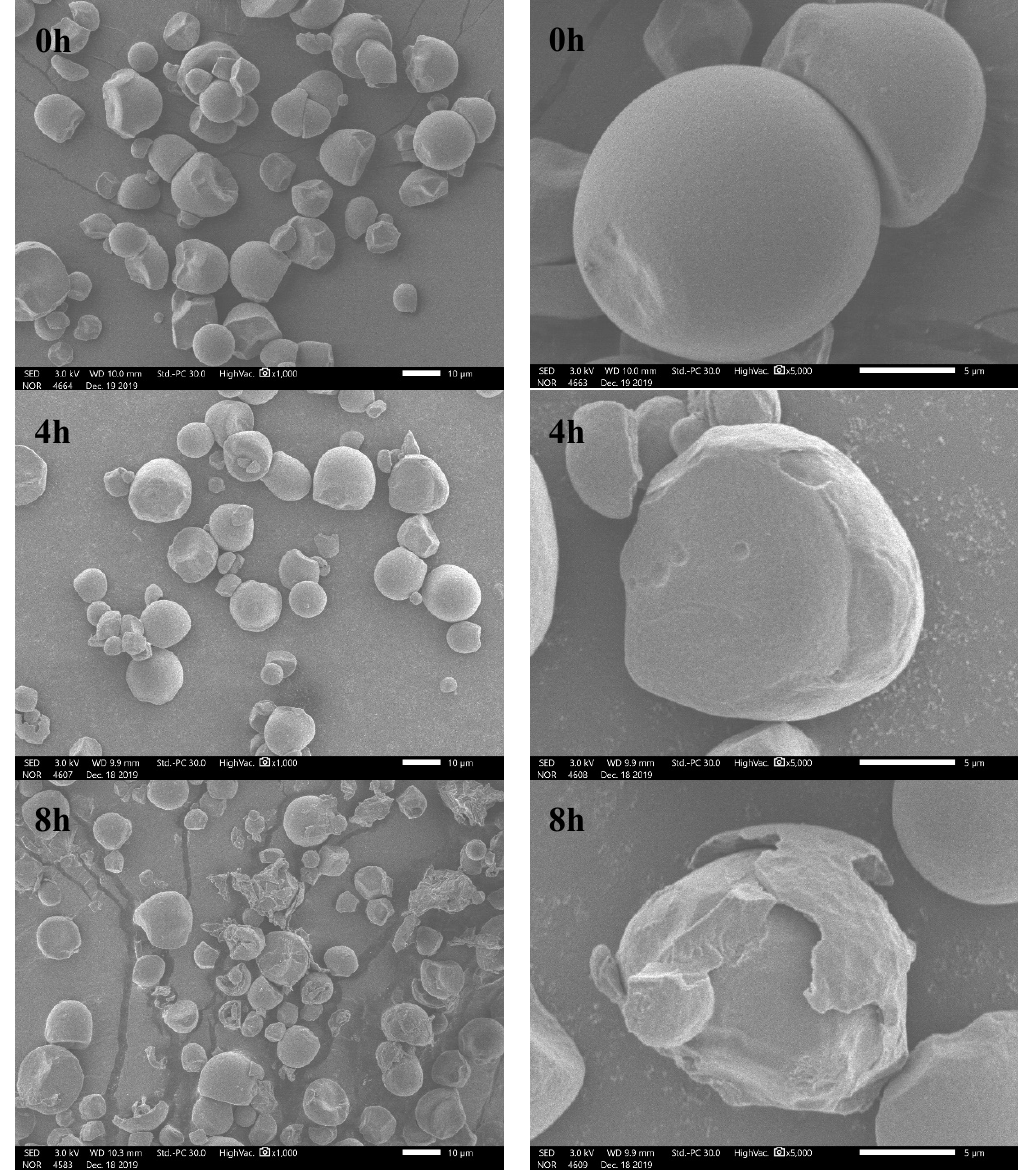
Figure 2. Scanning electron micrograph of cassava starch during hydrolysis (pretreatment at 50 °C, hydrolysis at 30 °C. Magnification 1000× (left) and 5000× (right)). Table 2. Adsorption parameters of amylases on cassava flour fitted to the Langmuir model.